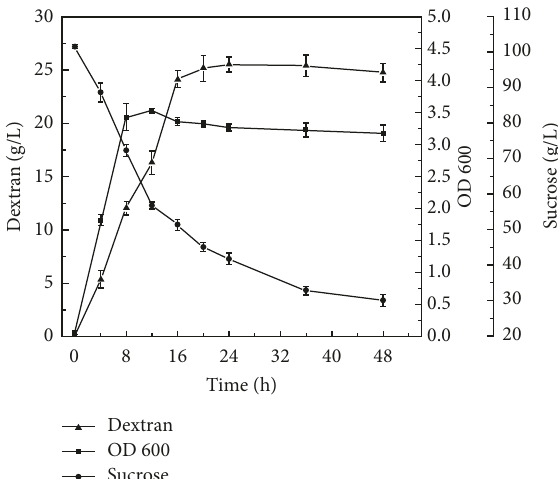
Figure 1: Time course of dextran production, cell growth, and sucrose consumption of W. confusa R003 in MRS medium pH 7.5, containing 10% w/v sucrose at 30 ∘ C with a shaking rate of 125